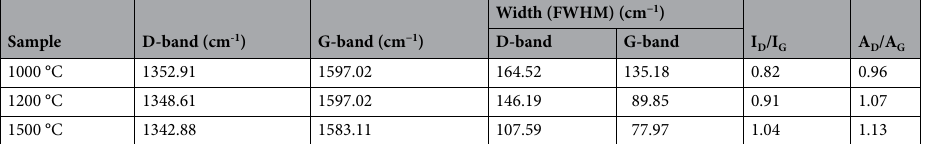
Table 2. Analysis of the position of the D and G-band in the Raman spectra for the carbonised lignin fibres and the full width at high maximum (FWHM) for these bands along with their intensity and area ratios.